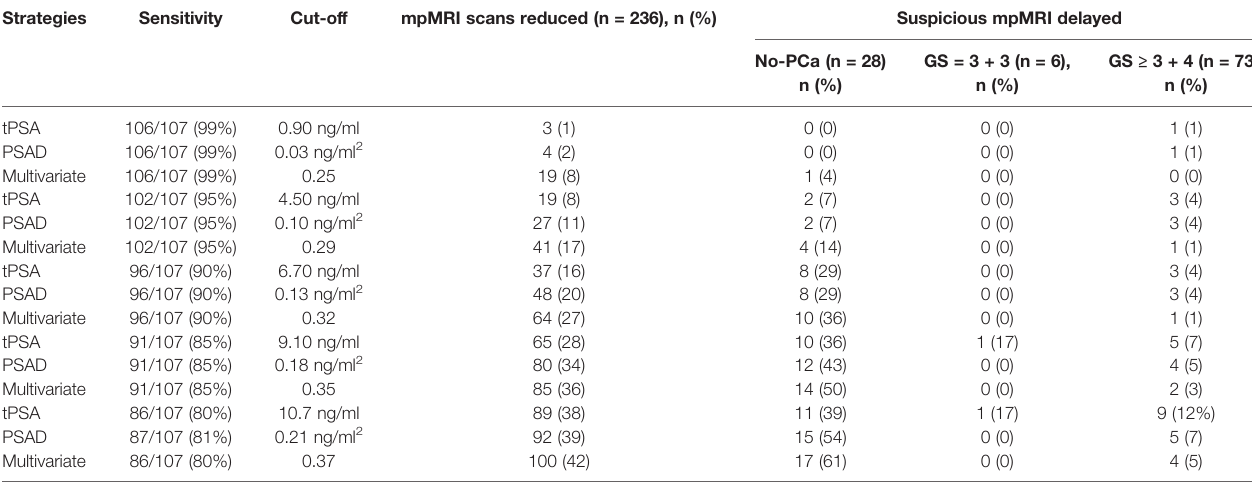
TABLE 3 | The diagnostic performance of tPSA, PSAD, and multivariate model in prediction of suspicious MRI-PCa in the validation cohort. Strategies